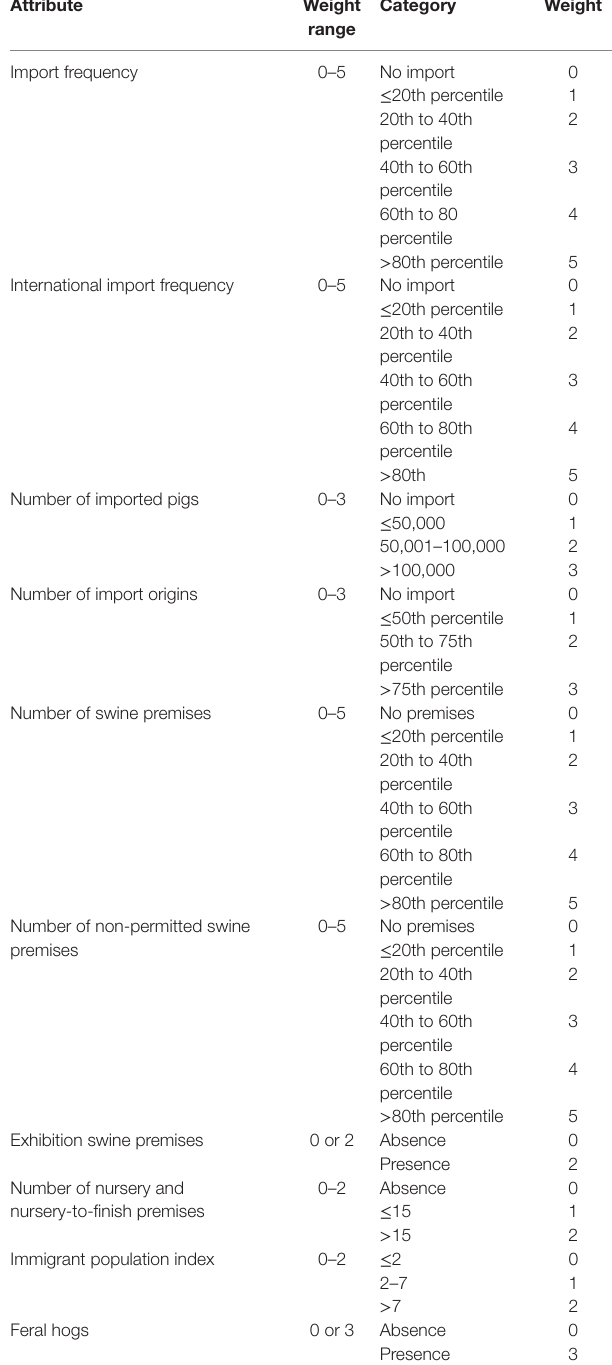
TaBle 2 | The scoring system for the county-level risk metrics for selecting the most likely classical swine fever outbreak scenarios in indiana, United